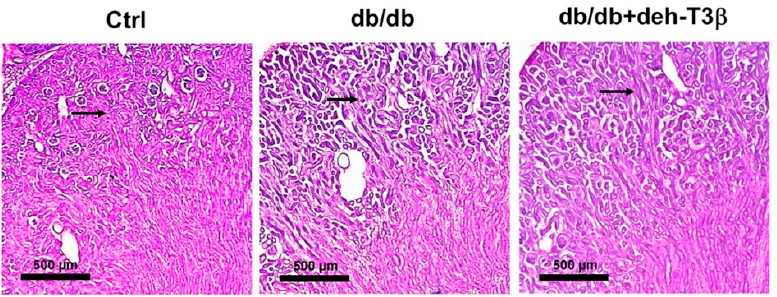
Figure 11. Histology of H&E-stained mice kidney sections. Ctrl wt C57Bl6 kidney, kidneys from non-treated db/db, and deh-T3β treated db/db mice for four weeks ad libitum.